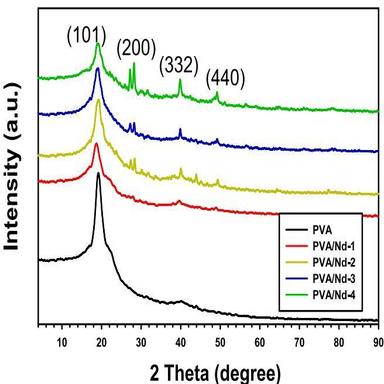
XRD spectrum of the PVA and the PVA/Nd2O3.